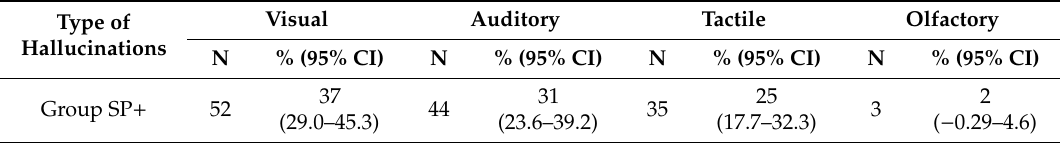
Table 2. The frequency of occurrence of hallucinations during sleep paralysis (SP) in the studied group of students.